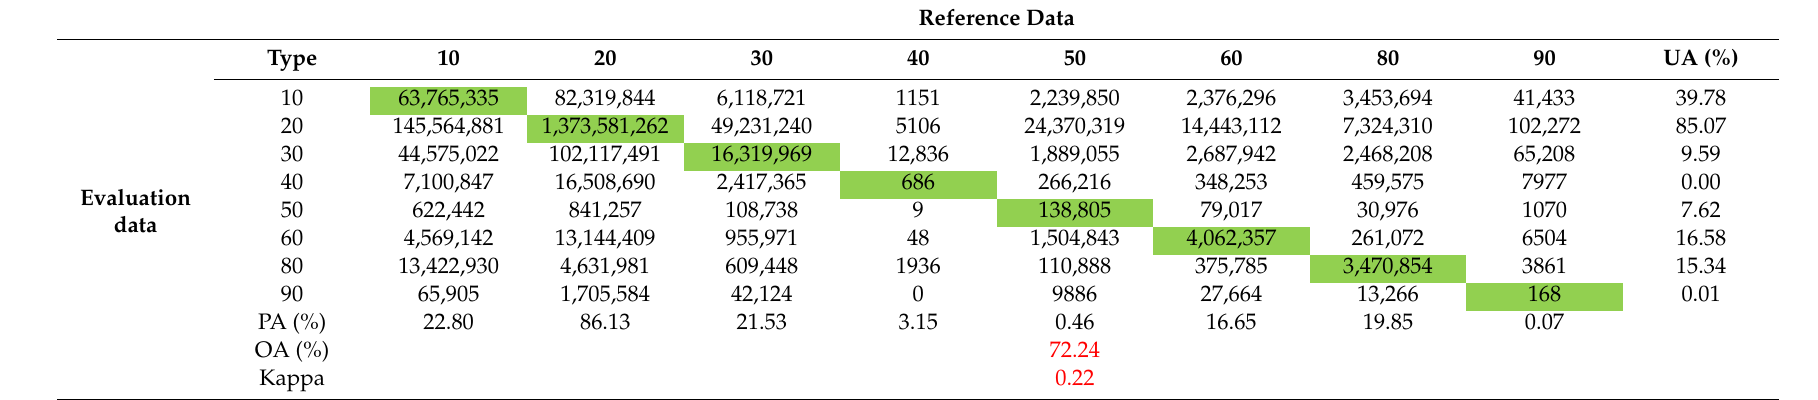
Table 6. Confusion matrix between FROM_GLC2015 and GlobeLand30-2010 (FROM_GLC2015 provides the reference data). Reference Data